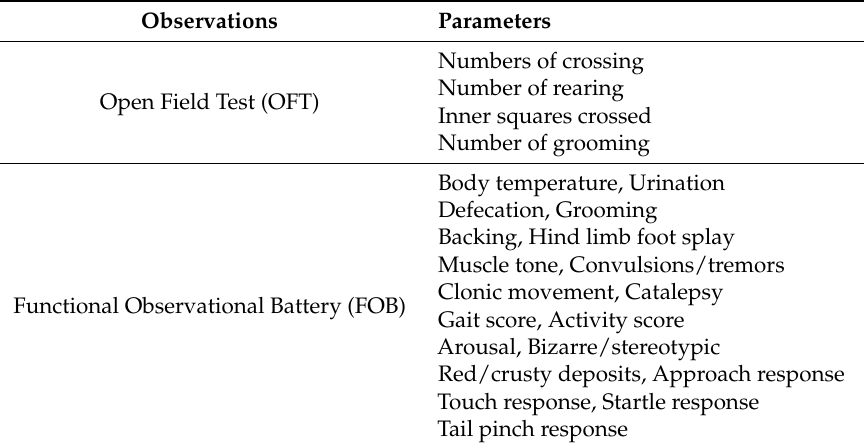
Table 1. Neurobehavioral